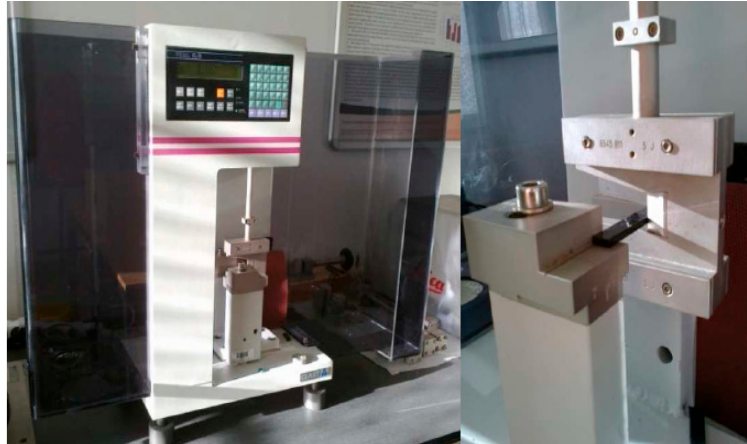
Figure 1. CEAST Resil 5.5 test device with sample location .